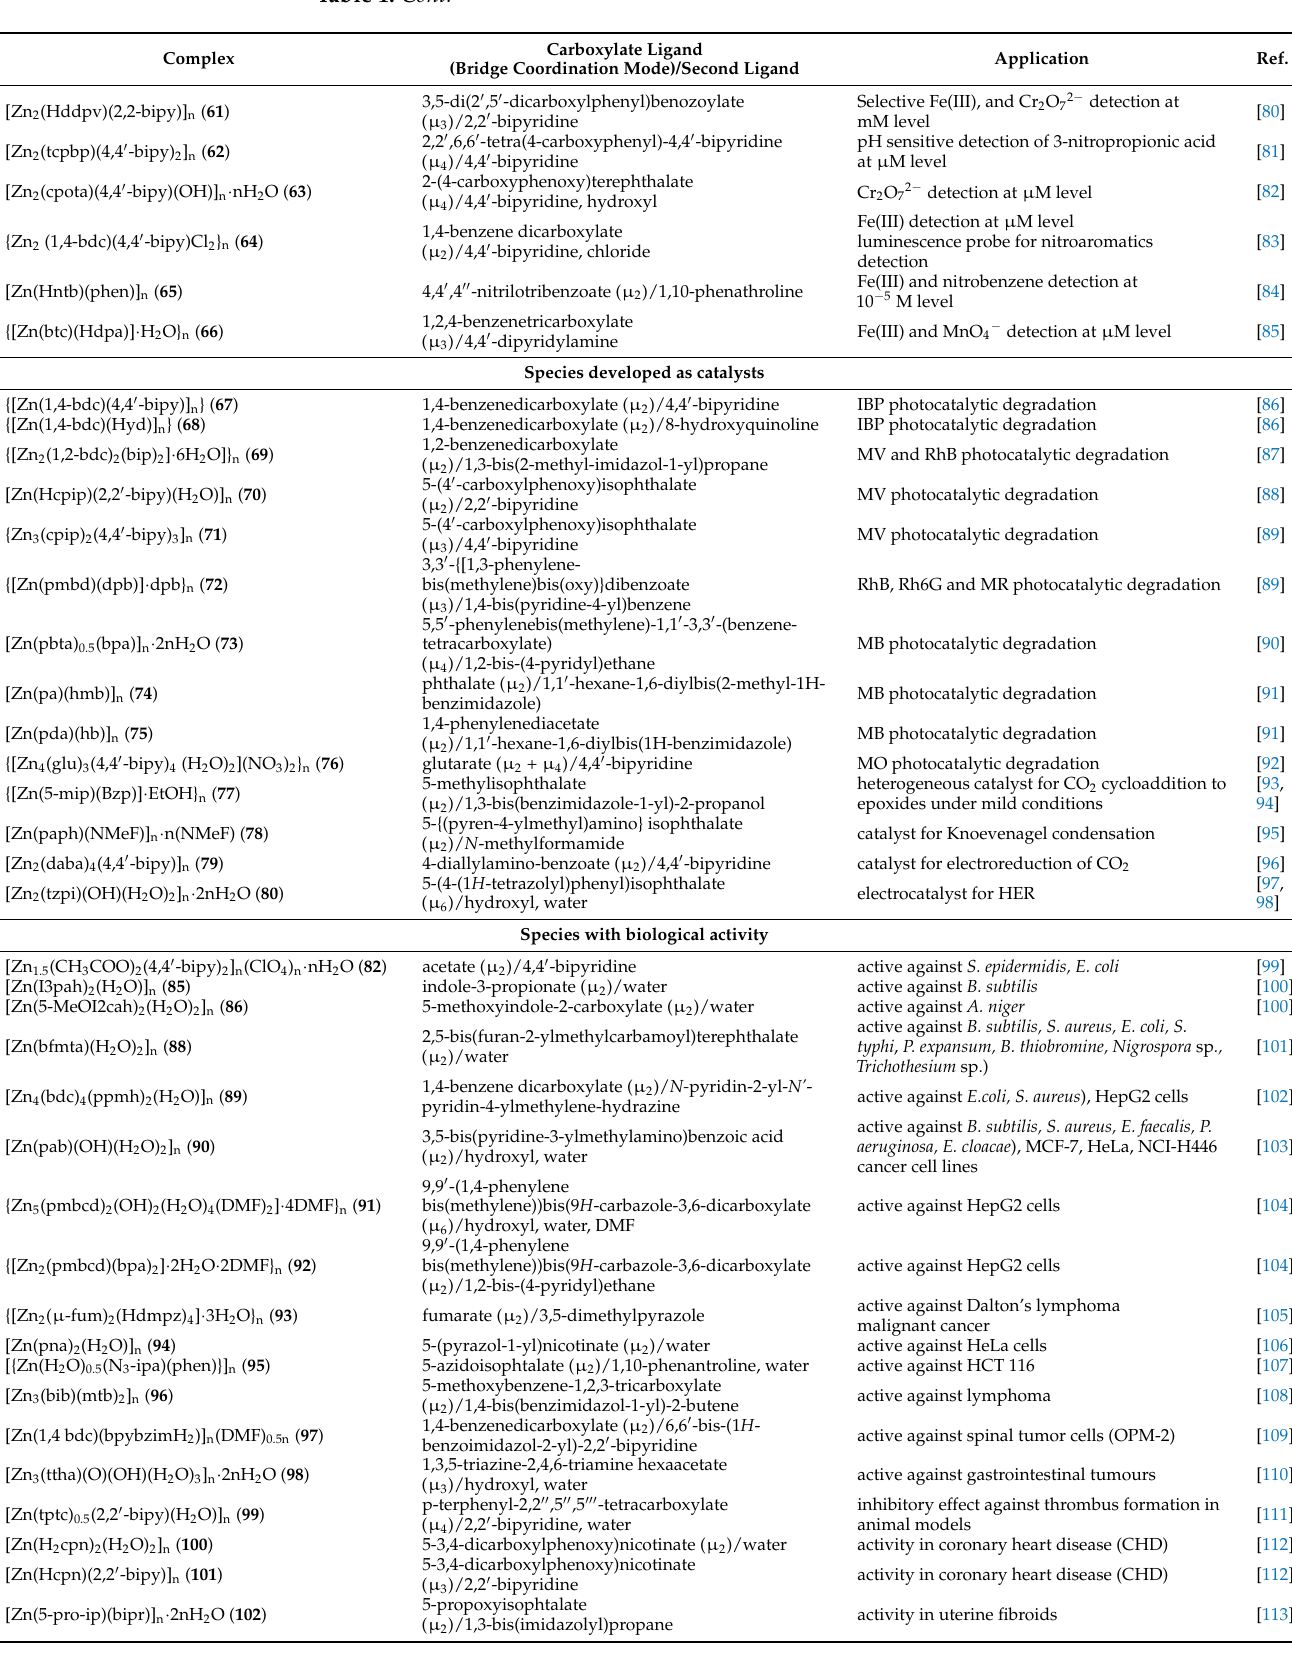
Table 1. Cont. Complex